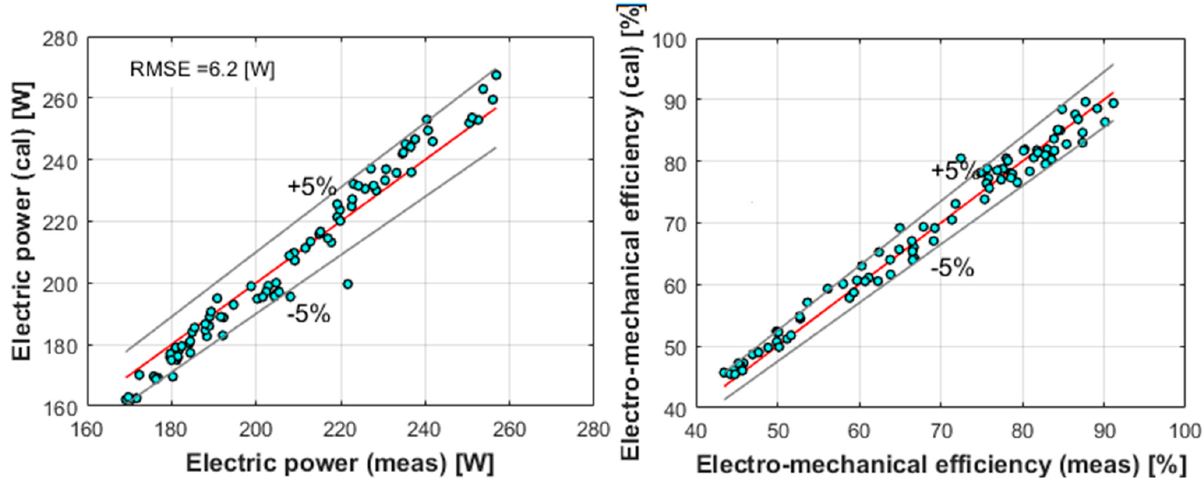
Figure 15. Measured and calculated pump electric power ( left )and electromechanical efficiency ( right ).